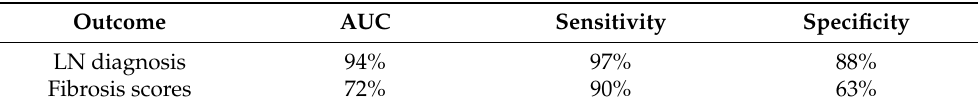
Figure 3. CKD progression as outcome. Characteristics of the ROC curve for the employed DKK3 Table 2. Diagnostic accuracy of DKK3 defined as dichotomic variable (1 = moderate/severe fibrosis cut-off. (ROC = receiver operating characteristic; DKK3 = Dickkopf-related protein 3; CKD = chronic vs. 0 = absent/mild fibrosis). (LN = lupus nephritis; AUC = area under the curve; DKK3 = Dickkopf- kidney disease). related protein